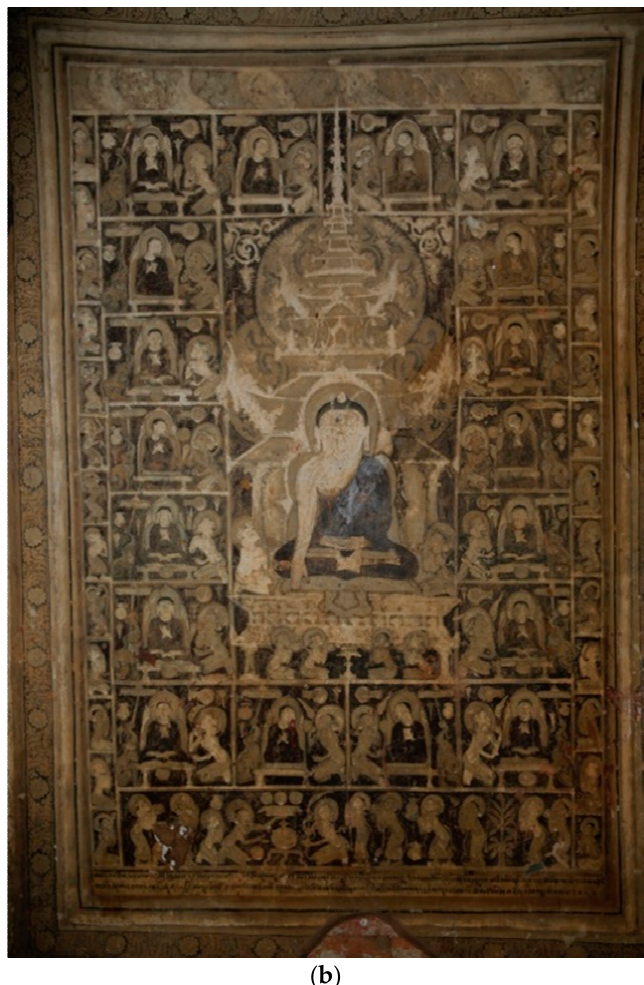
Figure 11. ( a ) Pagan, 13th century, endowment 585. ( b ) Pagan, 13th century, endowment 585. Big image illustrating king Pasenadi’s Asadisadana, the incomparable donation.